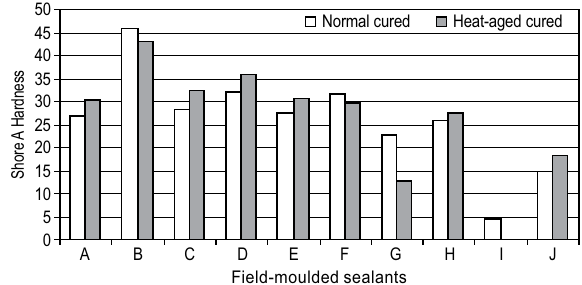
Fig. 2. Shore A Hardness of normal-cured and heat-aged FMS